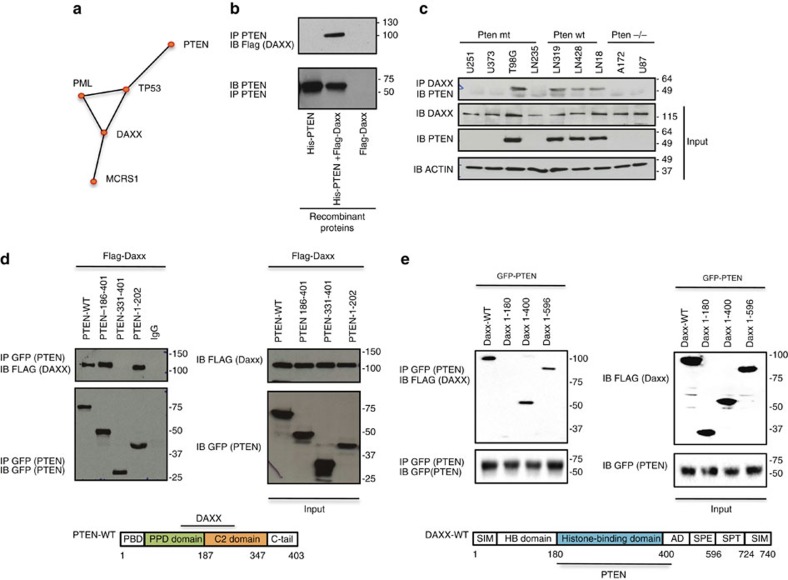
DAXX interacts with PTEN.(a) Predicted protein–protein interactions between PTEN, TP53, PML, DAXX and MCRS1 using the human protein interaction map. (b) In vitro pull-down using mixed Flag-DAXX and His-PTEN recombinant proteins immunoprecipitated (IP) with anti-PTEN and immunoblotted (IB) with anti-Flag. (c) Co-immunoprecipitation assay using whole cell protein lysates from different cell lines expressing endogenous DAXX and PTEN. IP anti-DAXX and IB anti-PTEN. (d,e) PTEN and DAXX interacting domains were mapped using 293 T cells co-transfected with Flag-Daxx-wt or GFP-PTEN and deletion constructs of each protein.